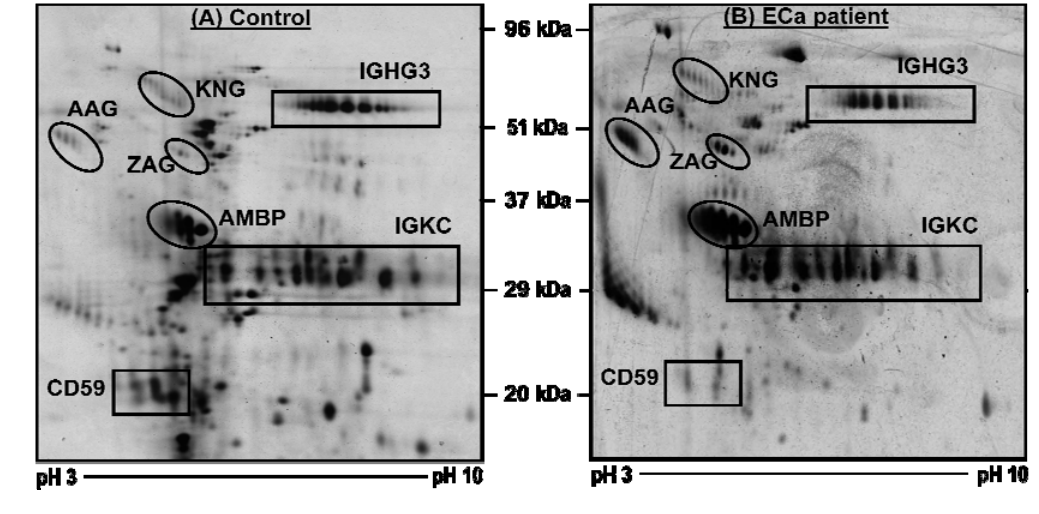
Figure 1. Typical two-dimensional gel electrophoresis (2-DE) urinary protein profiles. The labeled spot clusters are proteins which consistently appeared in profiles of control subjects. Panels ( A ) and ( B ) refer to the profiles of a control subject and a patient with stage IB endometrial cancer (ECa), respectively.